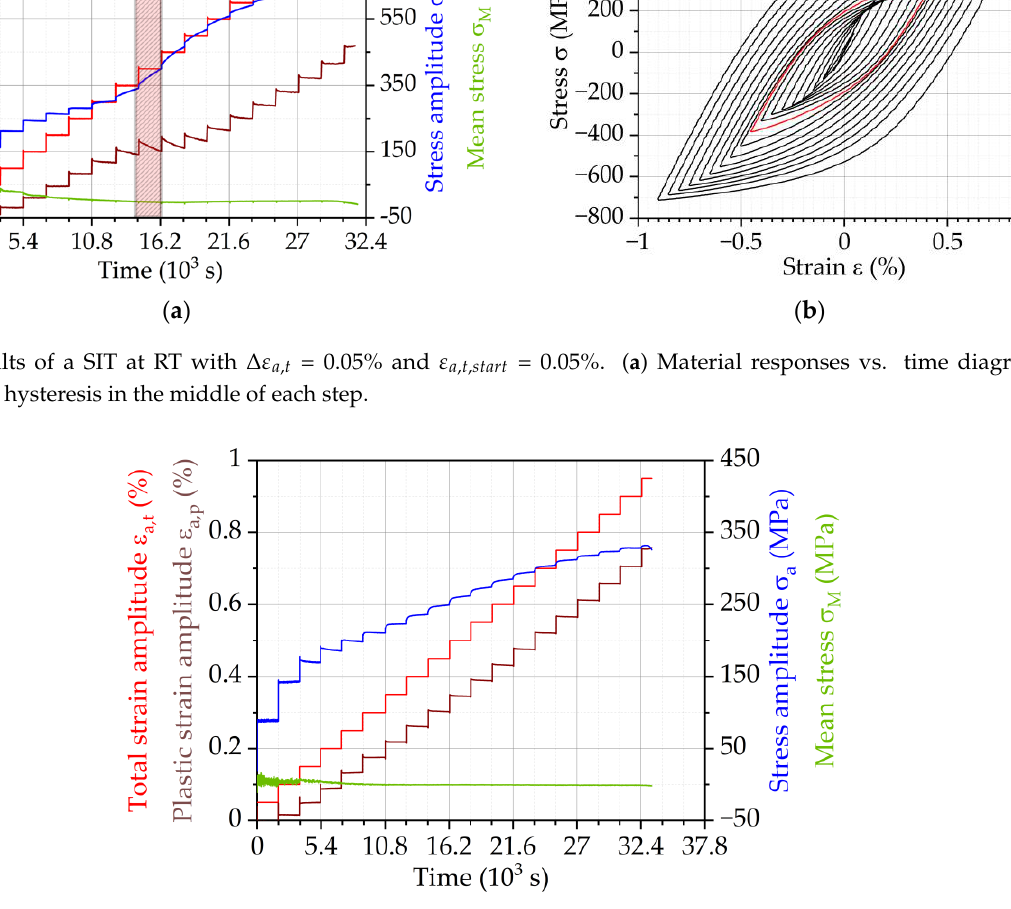
Figure 7. Results of a SIT at RT with 𝛥𝜀 𝑎,𝑡 = 0.05% and 𝜀 𝑎,𝑡,𝑠𝑡𝑎𝑟𝑡 = 0.05%. ( a ) Material responses vs. time diagram; ( b ) Stress- strain hysteresis in the middle of each step.